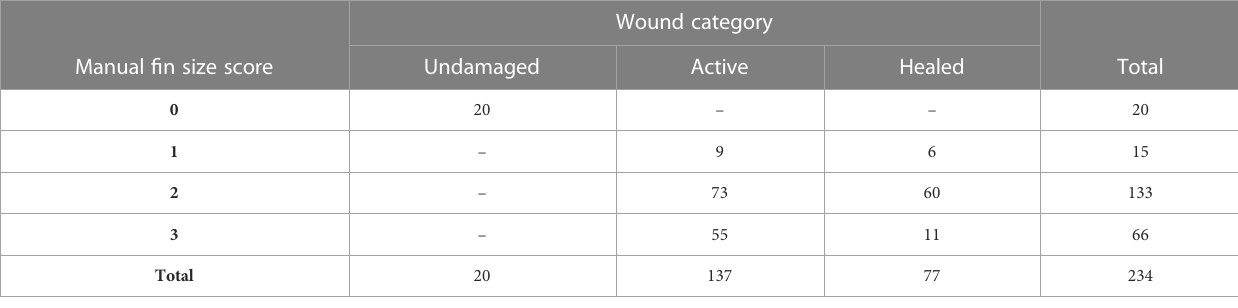
Manual fi n size score